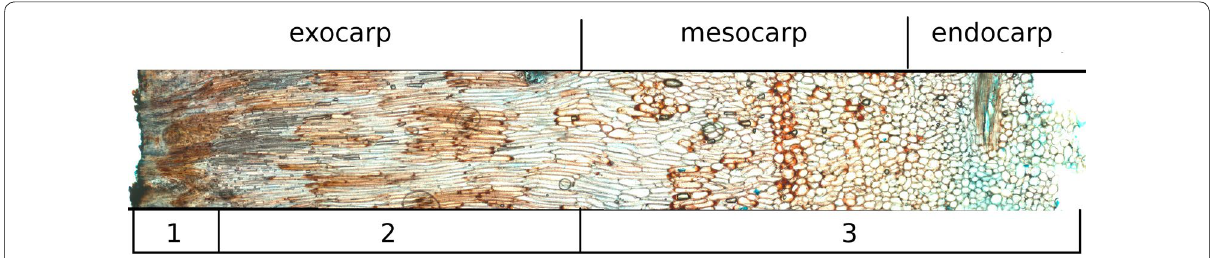
Fig. 3 Micrograph of A. digitata pericarp; shell thickness is approx. 7